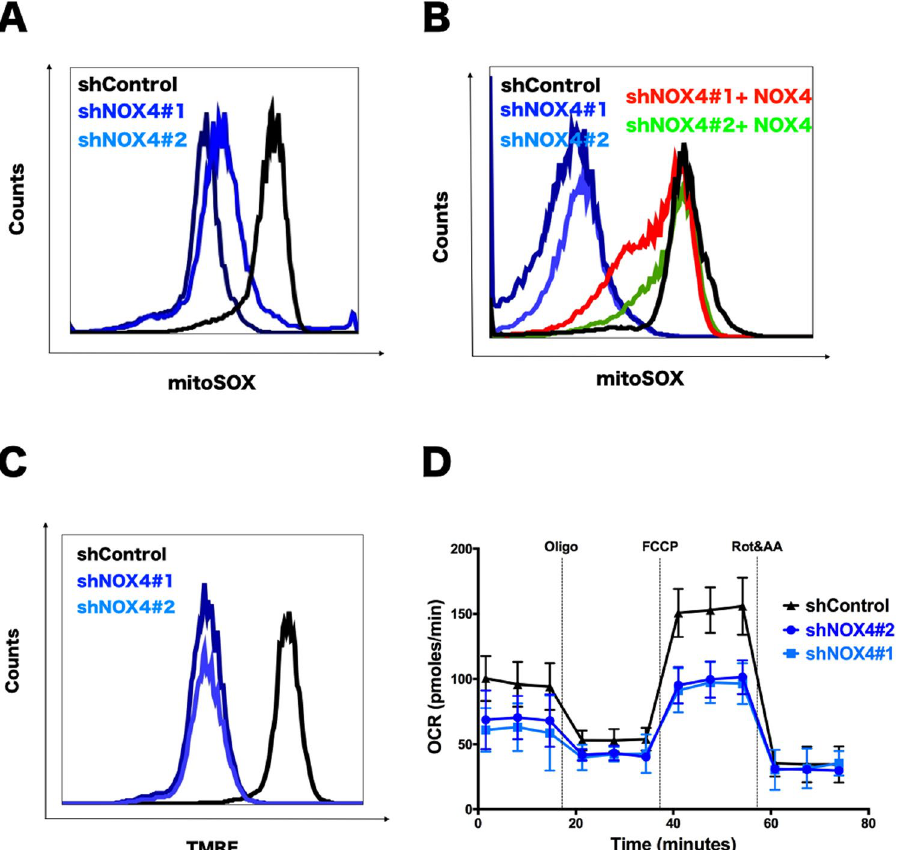
Figure 2. NOX4 is required for mitochondrial function in thyroid cancer during hypoxia. ( A,B) Mitochondrial ROS level was measured with MitoSox staining by flow cytometry analysis in TPC-1 cells cultured in 1% O 2 for 48 hours ( A ). NOX4 transfection can rescue mROS production decreasing after cell was treated with 1% O 2 for 48 hours ( B ). ( C ) Mitochondrial membrane potential assessed by TMRE (50 nM) staining of NOX4 knockdown TPC-1 cells. ( D ) Whole-TPC-1 cell oxygen consumption rate (OCR) in different groups. The dotted lines indicate the time of adding oligomycin (1 μ M), FCCP (1 μ M) and rotenone and antimycin A (Rot/AA, 1 μ M